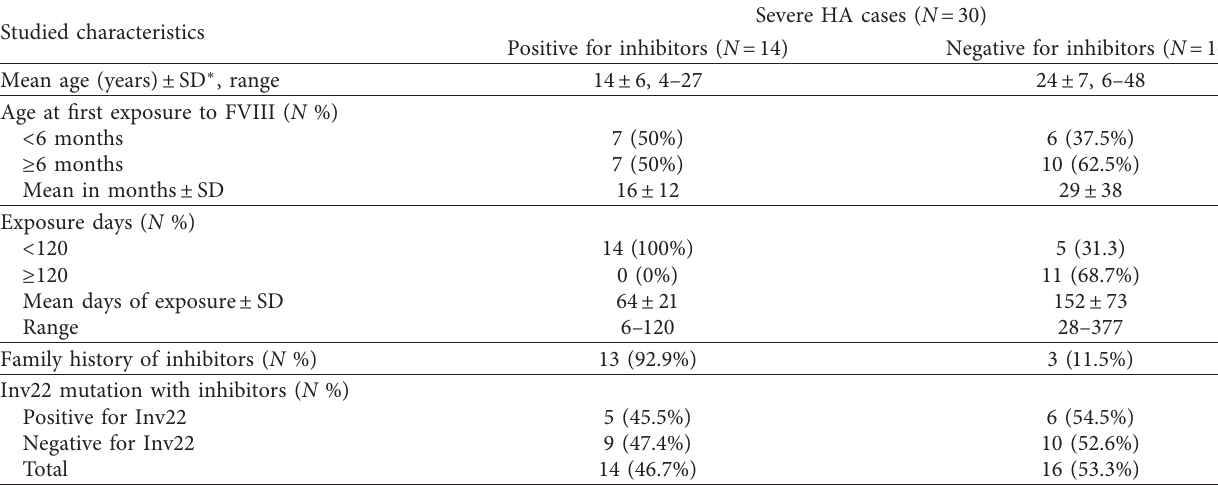
Table 3: Severe HA patients’ studied characteristics with regard to age, age at first exposure to FVIII concentrates, exposure days, family history of inhibitors, and inhibitors production with respect to Inv22.